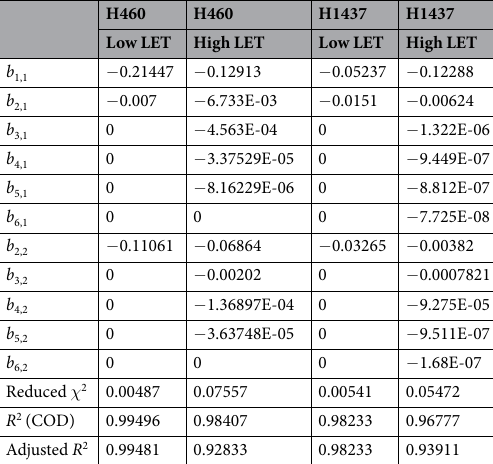
Table 1. Numerical values of expansion coefficients in α and β given in Eqs (3 and 4) for H460 and H1437 cell survivals. For a beam proton with energy 80 MeV the transition between low and high LETs occurs at LET ≈ 10 keV / μ m . The reduced chi-square, χ 2 , the coefficients of determination (COD), R 2 , and adjusted R 2 have presented to illustrate the goodness of the fitting